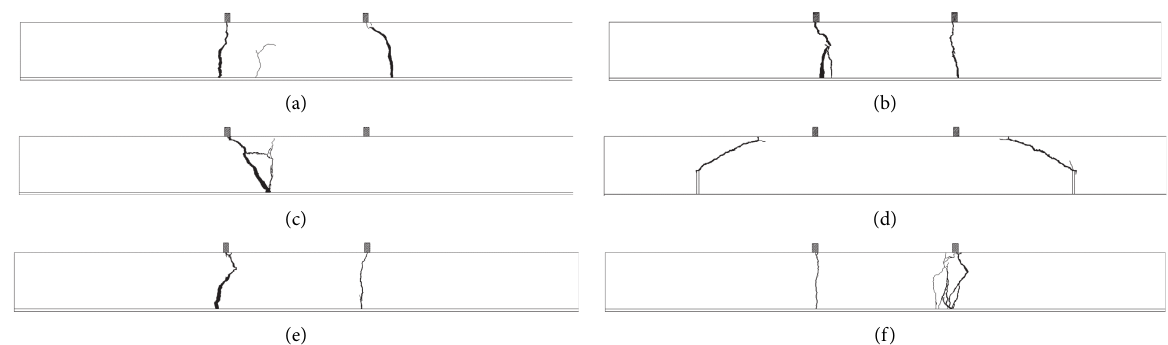
Figure 8: The main crack distribution of the specimen: (a) SP1, (b) SP2, (c) SP3, (d) SP4, (e) SP5, and (f) SP6.